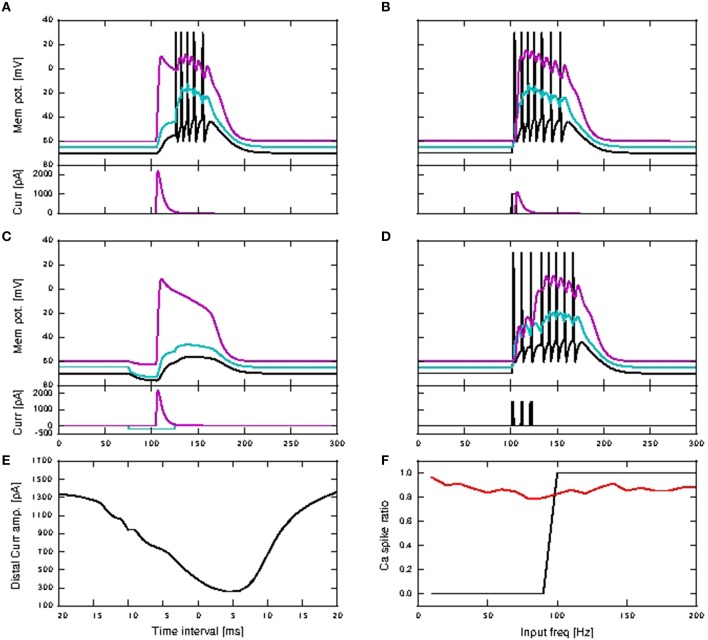
Simulation results for modified three-compartment model which reproduces the critical frequency property. (A–D) Top panels show the membrane potentials for each compartment against time inms (black: soma, cyan: proximal, magenta: distal), while the lower panels show the corresponding DC stimulation injected at each compartment against time inms. See main text for the stimulation details. (E) Minimum amplitude of the beta current at the distal compartment required to trigger a calcium spike when applied together with the somatic step current as in (B). (F) Calcium spike ratio (proportion of step current stimuli that trigger a calcium spike) as a function of input frequency for the neuron with modified parameters in the case of no background noise (black) and with background noise (red).